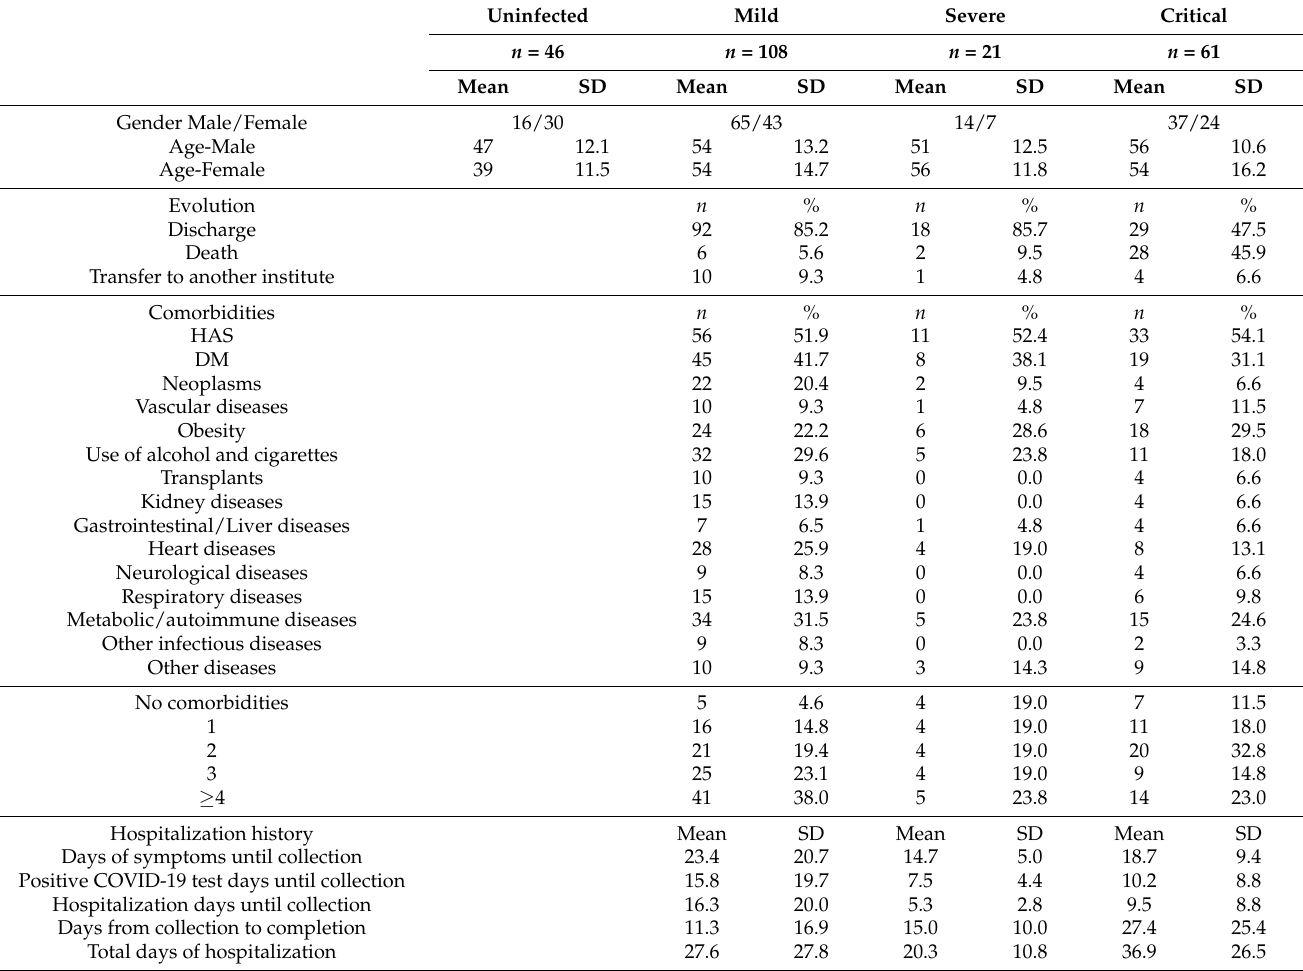
Table 1 Demographic data of the COVID-19 patient cohort and control subjects used in the study. Data on age, evolution, and comorbidities of control subjects and COVID-19 patients classified as moderate, severe, and critical. M–male; F–female; SC–healthy control; n–sample number; SAH–systemic arterial hypertension; DM–diabetes